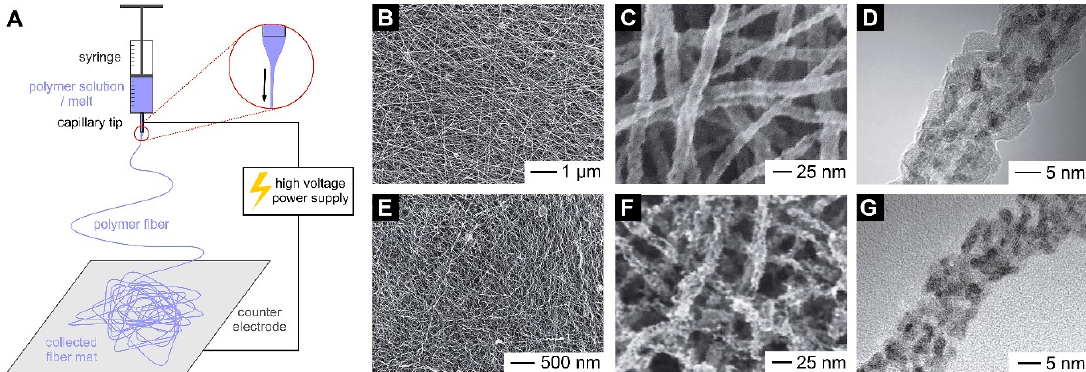
Figure 11. ( A ) Scheme of the fabrication of nanofiber networks with electrospinning. ( B – D ) Electron micrographs showing Fe-Pt nanowires, electronspun using Fe(NO 3 ) 3 and H 2 PtCl 6 as the metal sources, followed by pyrolytic removal of the polymer carrier PVP, and reduction in H 2 . ( E – G ) Fe-depleted porous Fe-Pt alloy nanowire network obtained from the nanowires shown in ( B – D ) via dealloying. ( B – G ) Reprinted (adapted) with permission from [136]. Copyright (2011) John Wiley and Sons.